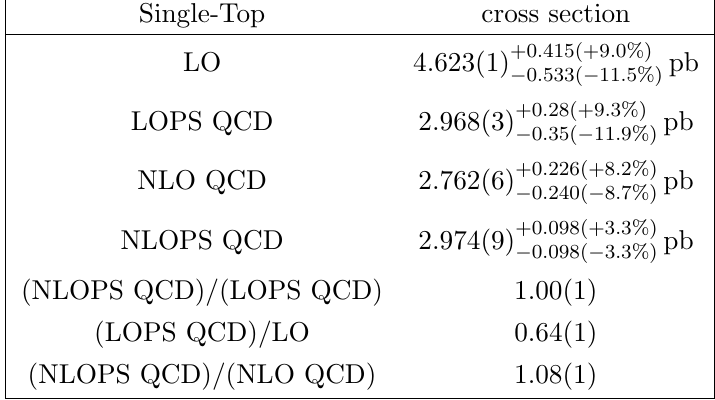
Table 3 . Total cross section and scale uncertainty in various QCD approximations for the signa- ture (2.1) from Single-Top production within the (cid:12)ducial region de(cid:12)ned in section 3.1. The ratios are computed from the central values of their corresponding